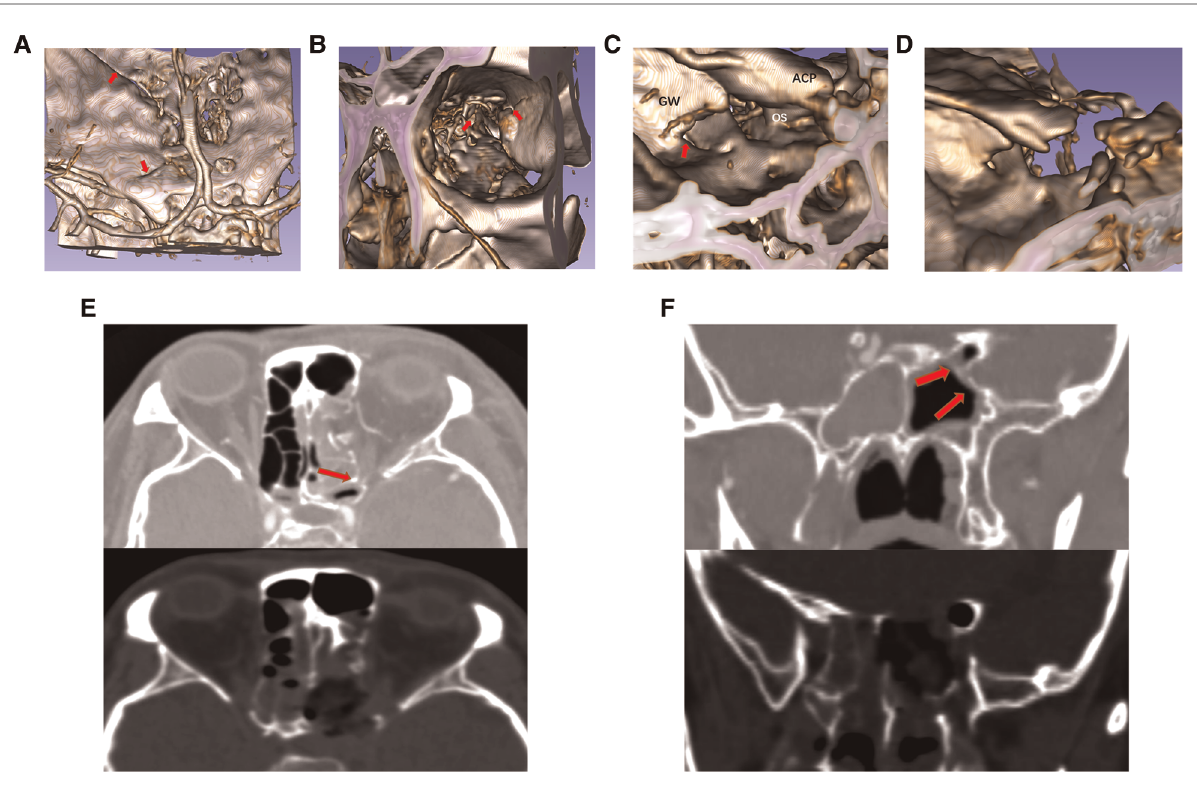
FIGURE 5 Comparison of preoperative and postoperative imaging data. 3D views of patients ’ left orbit from different angles are shown in ( A – C ). The red arrow indicates the fracture line. ( A ) The fractures of the small wing of the sphenoid bone involve the superior wall of the optic nerve. ( B ) Fracture line of the superior orbital fi ssure from the orbital perspective. ( C ) Observation of the fracture line of the superior orbital fi ssure from the upper left of the skull base. ( D ) Thin-slice CT 3D reconstruction image after surgery. The preoperative (top) and postoperative (bottom) images of the patients are shown in E-F. The red arrow indicates the fracture line. ( E ) Comparison of preoperative and postoperative cranial axial CT fi ndings. ( F ) Comparison of preoperative and postoperative coronal cranial CT fi ndings. The upper red arrow indicates the optic canal fracture line, and the lower red arrow indicates the fracture line on the superior medial wall of the superior orbital fi ssure (corresponding to the oculomotor nerve fi ssure